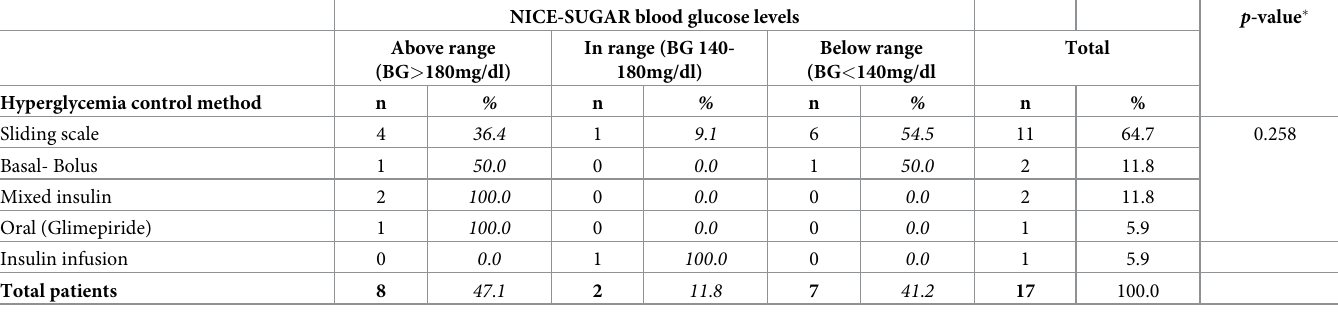
Table 4. Glycaemic levels of patients by hyperglycaemia control methods (n =